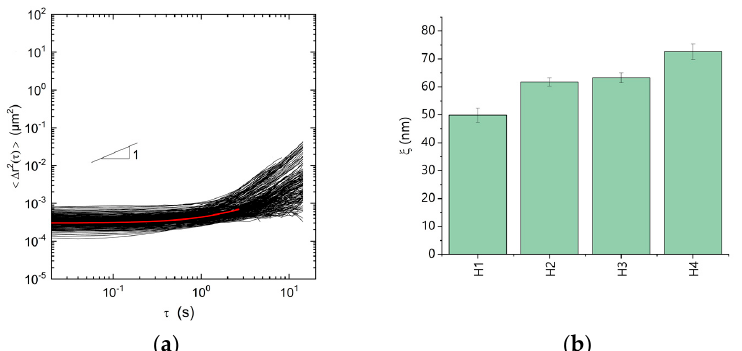
Figure 4. Multiple particle tracking (MPT) microrheology analysis of local viscoelastic properties of different types of PAD hydrogels (H1–H4, specified in Figure 3). ( a ) Mean square displacements (MSDs) (black curves) of individual fluorescent marker beads of diameter 200 nm dispersed in the hydrogel H1. The red curve is the ensemble ‐ average MSD. ( b ) Comparison between mesh size values ξ as deduced from MPT experiments for the different hydrogels. All experiments were carried out in duplicates. Note that the experimentally determined mesh correlate with the fraction of crosslinking proposed for hydrogel samples H1–H4.